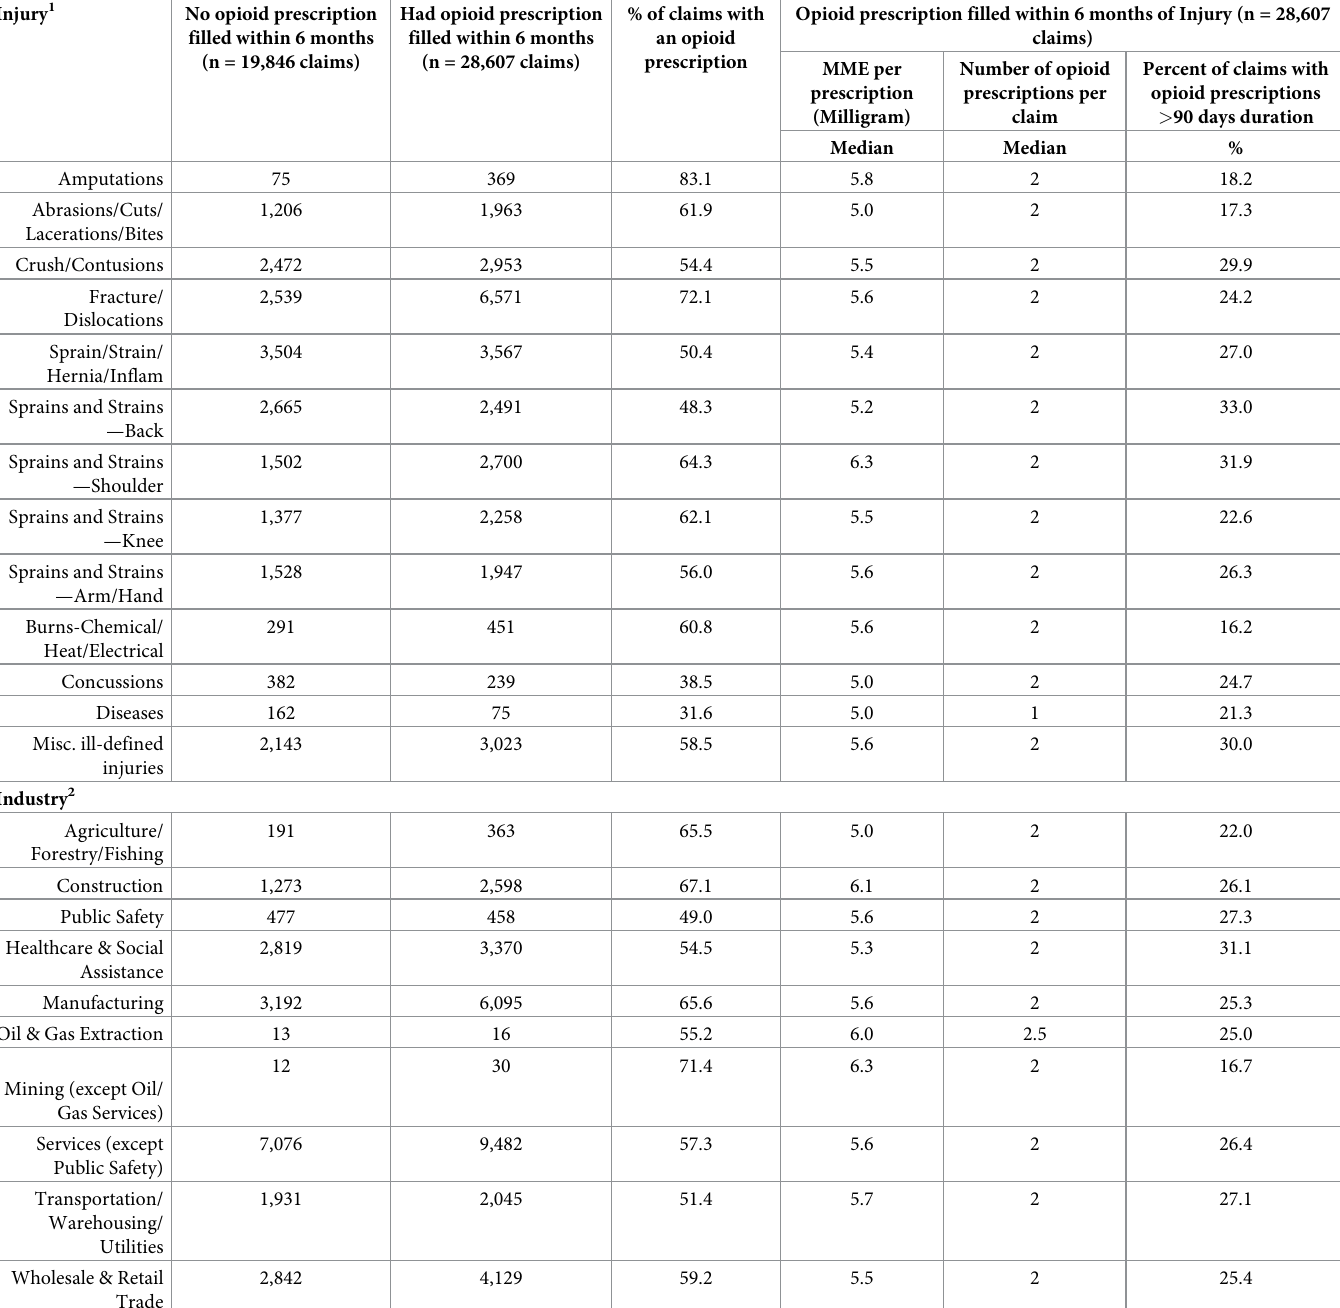
Table 3. Percent of claims with an opioid prescription, median MME per prescription, median number of opioid prescriptions per claim and percent of claims with opioid prescriptions > 90 days duration by injury type and industry within 6 months of a paid wage replacement WC claim, 2016–2018 combined (n = 48,453